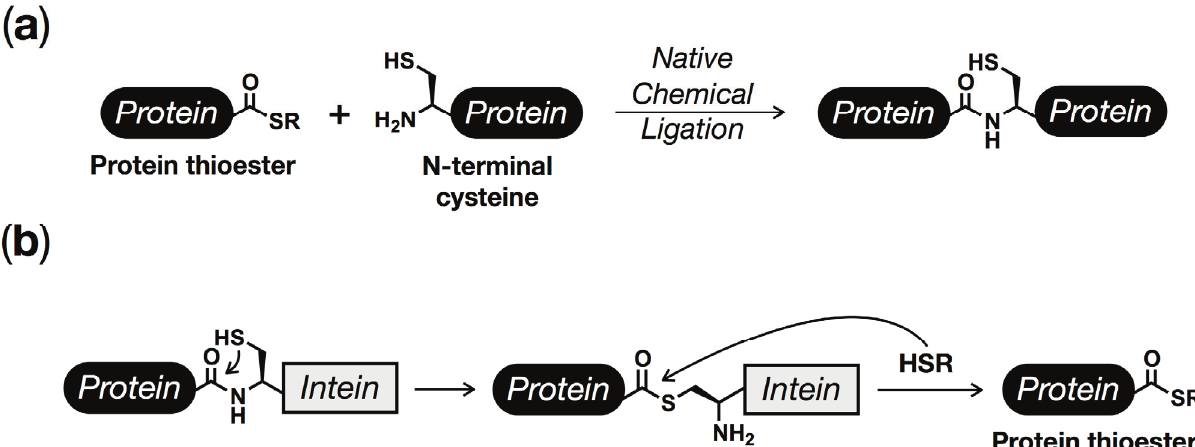
Figure 2. Protein synthesis using ligation chemistries. ( a ) Native Chemical Ligation (NCL) enables the selective reaction of protein or peptide thioesters with N-terminal cysteine residues, allowing for the generation of native peptides bonds under physiological conditions and without any protecting groups. ( b ) Inteins can be exploited to generate recombinant protein thioesters that can be used in NCL reactions, which has been termed Expressed Protein Ligation